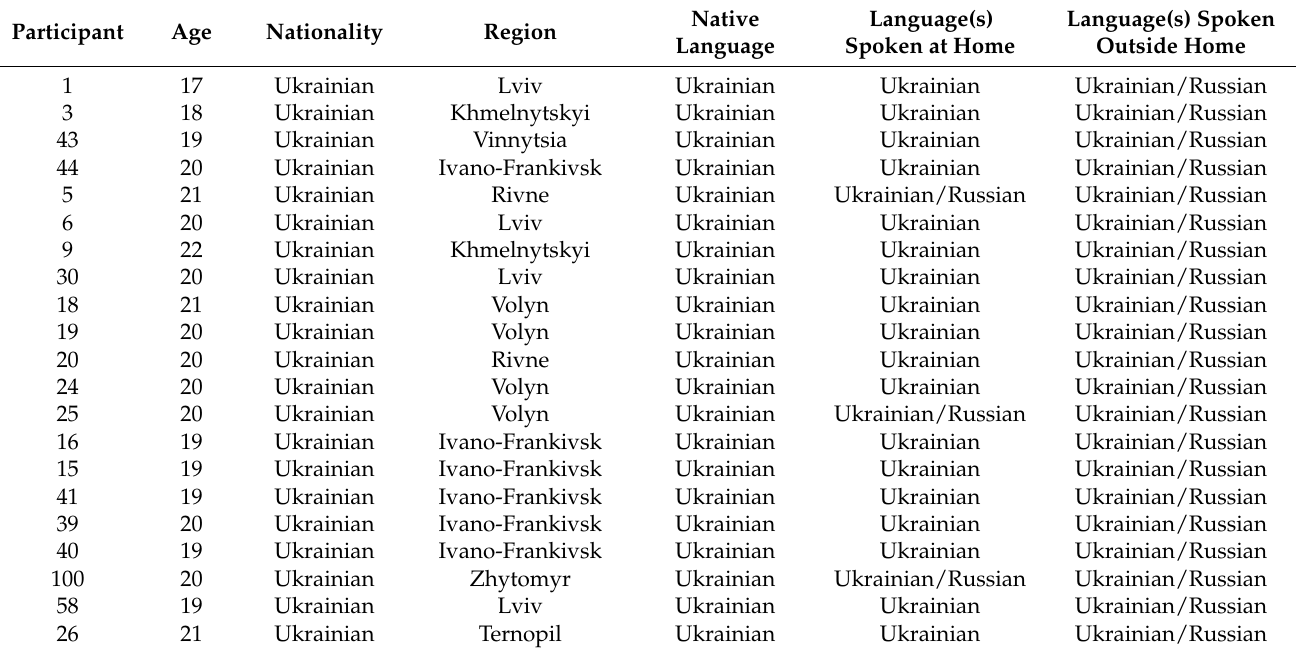
Table A2. Biodata: age, nationality, region, native language and language(s) spoken at home.